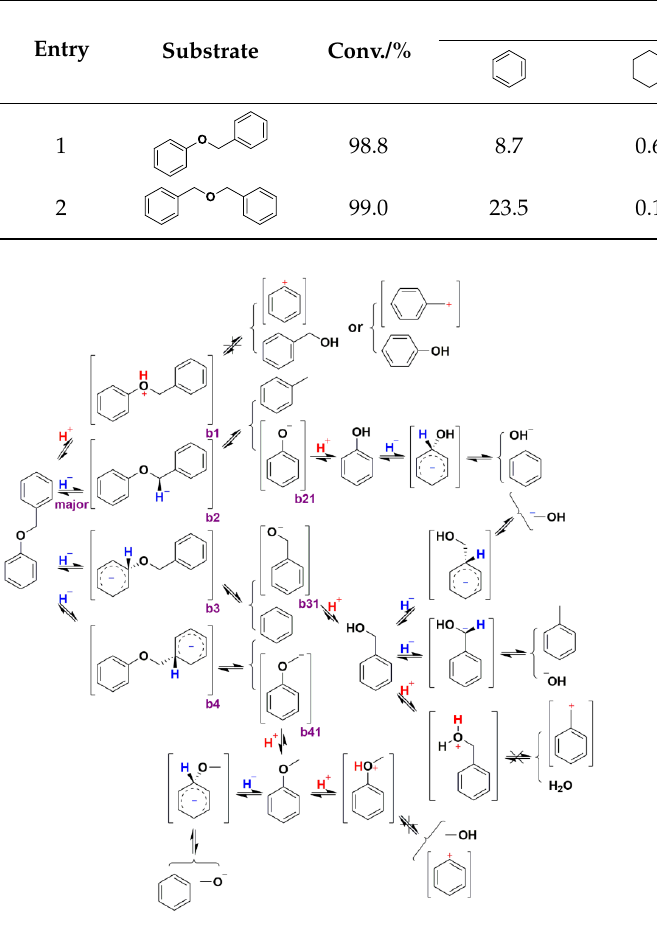
Table 3. Hydrogenolysis of benzyl phenyl ether and dibenzyl ether over RuCoP/SiO 2 .